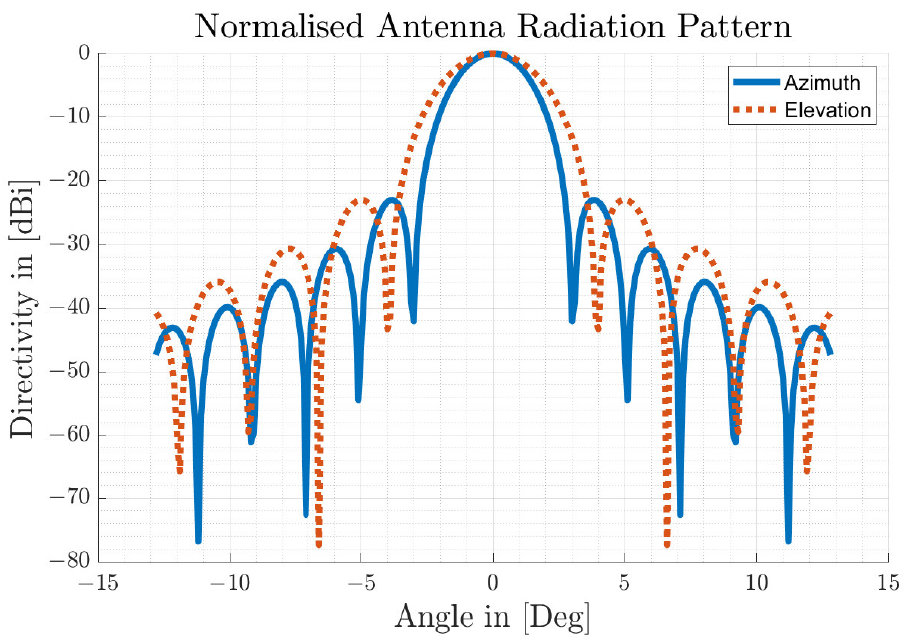
Figure 4. Synthetic antenna radiation pattern.